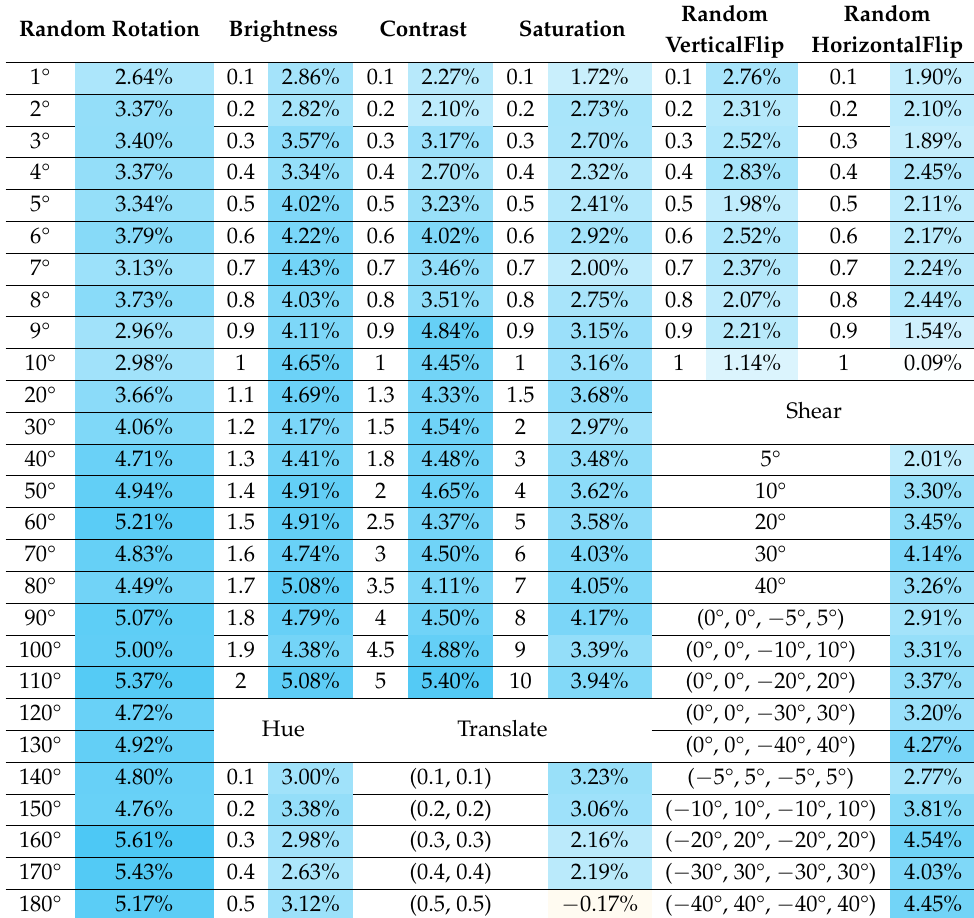
Table A1. Performance of DA methods on Γ train 100 . This table indicates the augment effect of different PAP DA methods and parameters applied on Γ train 100 when setting seed to 350. The displayed percentage PAP values describe the increase/decrease of mAA in percent. The value is color-coded from blue (increase in accuracy) over white (no effect) to orange (decrease in accuracy). The four DA methods with the best effect are still RandomRotation, Brightness, Contrast, and Shear. These four methods can obtain their best enhancement effect on Γ train 100 with parameters 160°, 2, 5, and ( − 20°, 20°, − 20°, 20°), PAP respectively. The trend of the effect of different parameters is similar to that of Γ train 50 , but with fewer PAP increments for the average accuracy.